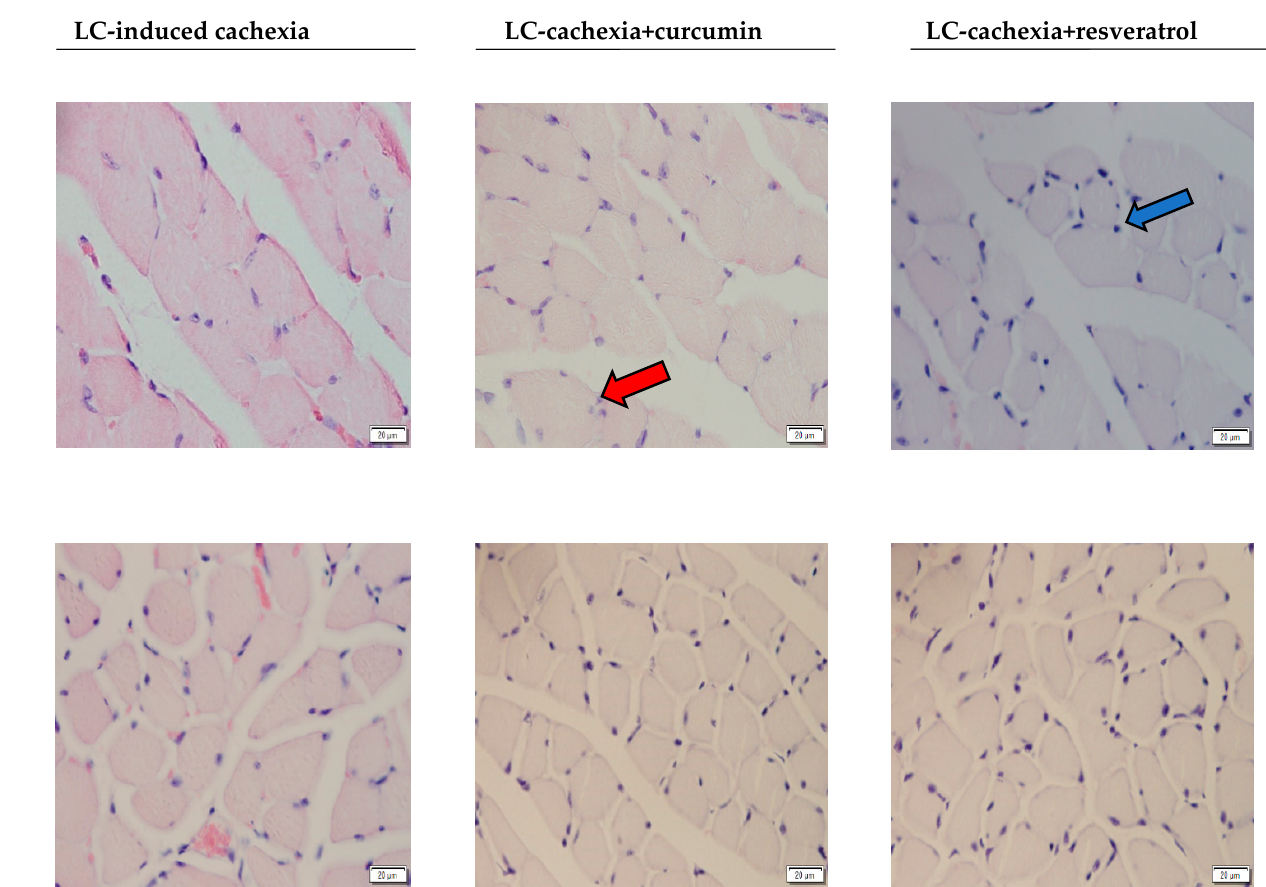
Figure 3. Representative images of cross gastrocnemius ( A ) and soleus ( B ) muscle sections with H&E staining. An example of an internal nucleus (red arrow) and an inflammatory cell (blue arrow) are indicated.